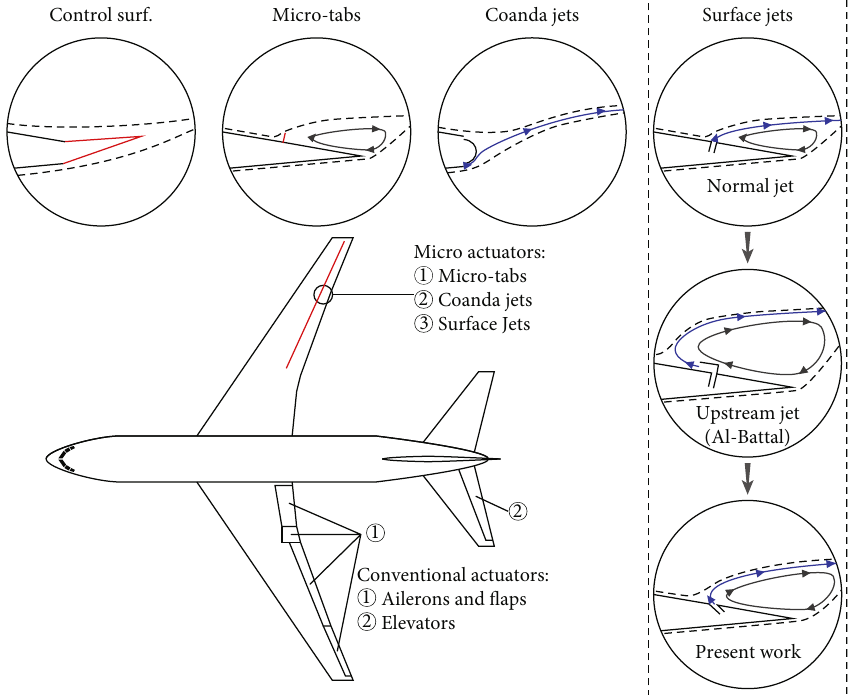
Figure 1: The illustration of various load control